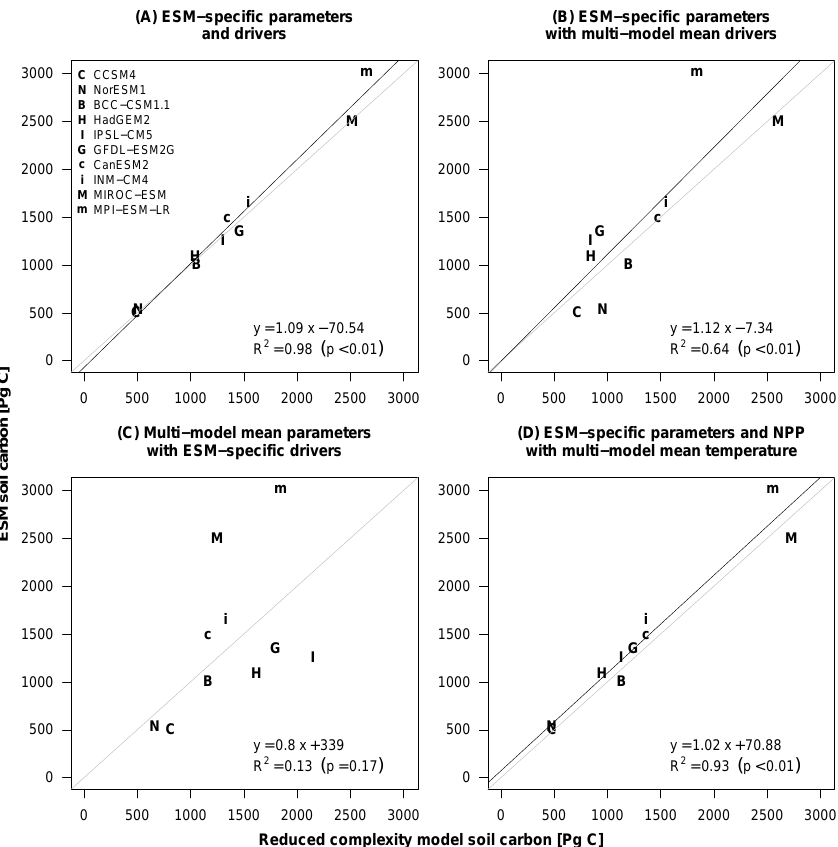
Fig. 5. Relationship between global soil carbon totals from ESMs and global soil carbon totals predicted by reduced complexity models (Eqs. 4–7). The reduced complexity model in (A) used ESM-specific parameters and drivers (Eq. 4); (B) used ESM-specific parameters with multi-model mean NPP and soil temperature (Eq. 5); (C) used multi-model mean parameters and ESM-specific NPP and soil temperature (Eq. 6); (D) used ESM specific parameters and NPP but multi-model mean soil temperature (Eq. 7). The gray line indicates a 1 : 1 fit and the black line is the linear